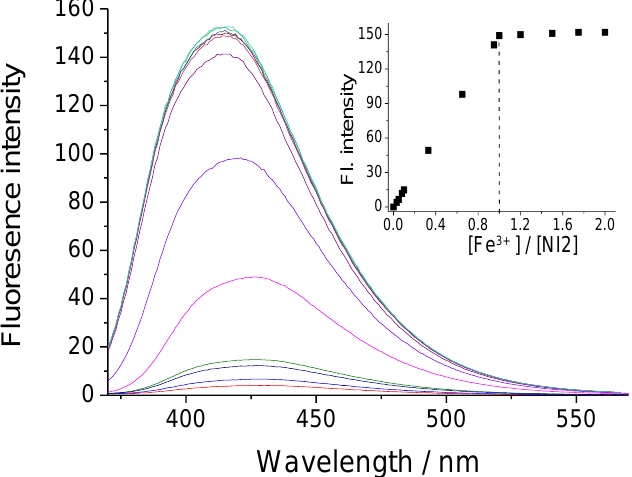
Figure 4. Fluorescence spectra of NI2 (c = 1 × 10 −5 mol L −1 ) at various concentrations of Fe 3+ cations (from 0 to 1.5 × 10 −5 mol L −1 ).